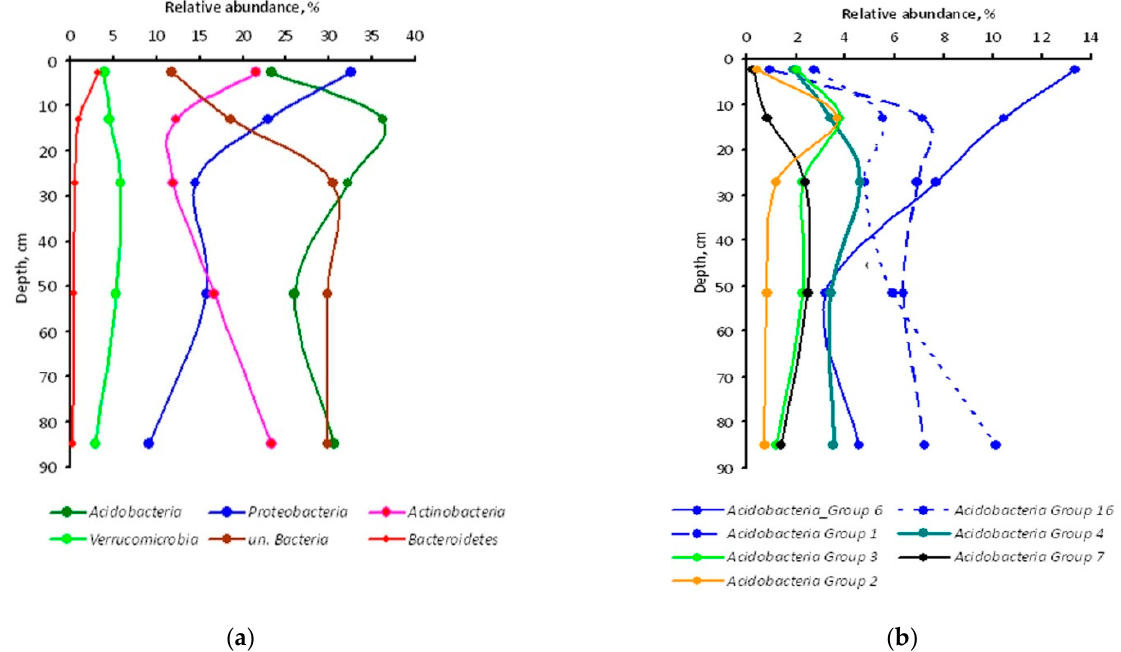
Figure 2. Relative abundance of bacterial taxa in genetic horizons of the undisturbed Grey-Luvic Phaeozem under birch forest in the south of West Siberia: phyla ( a ) and classes of Acidobacteria phylum ( b ) The markers show the means of three individual soil